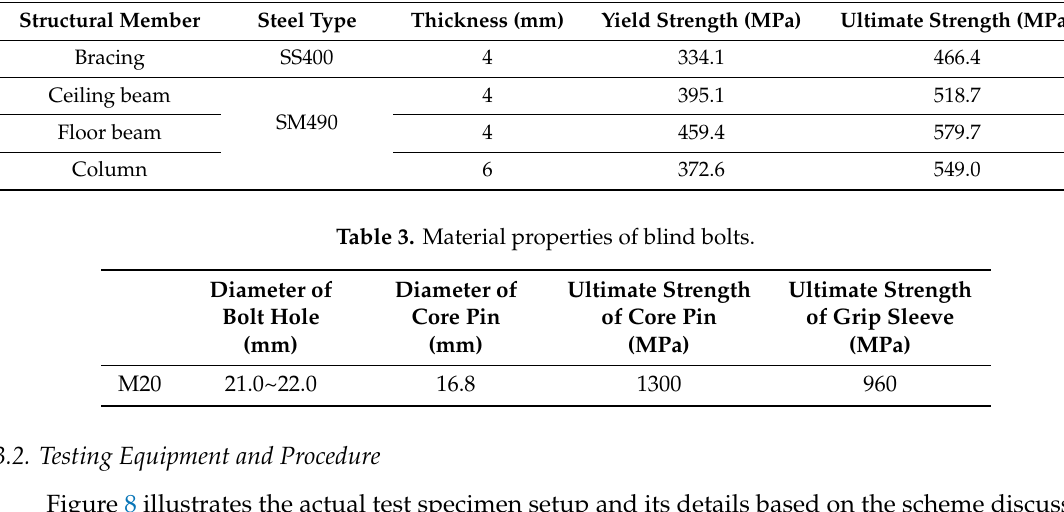
Figure 7. Details of specimen IC_OB_B. Table 2. Material properties of the structural members used in the test specimens.